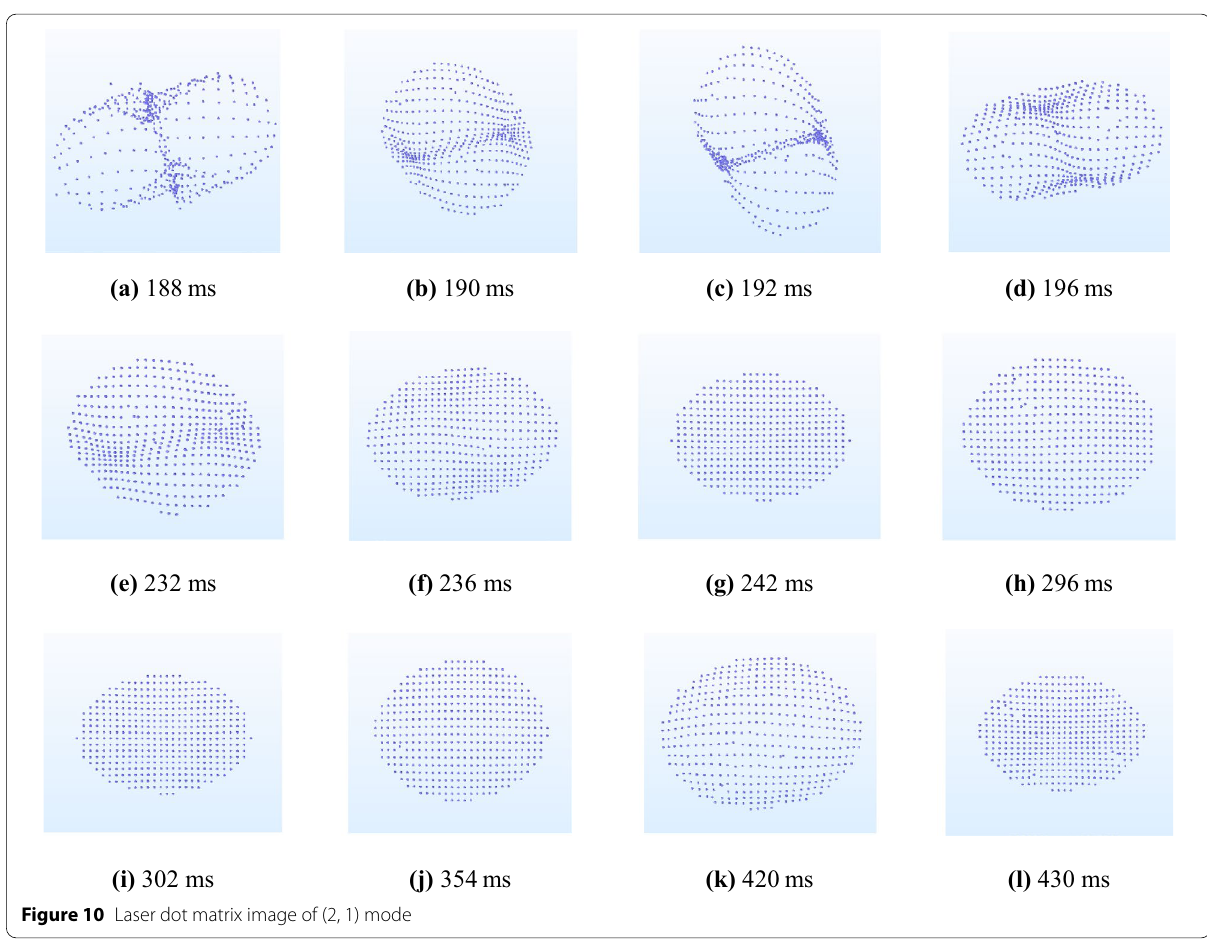
Figure 10 Laser dot matrix image of (2, 1) mode